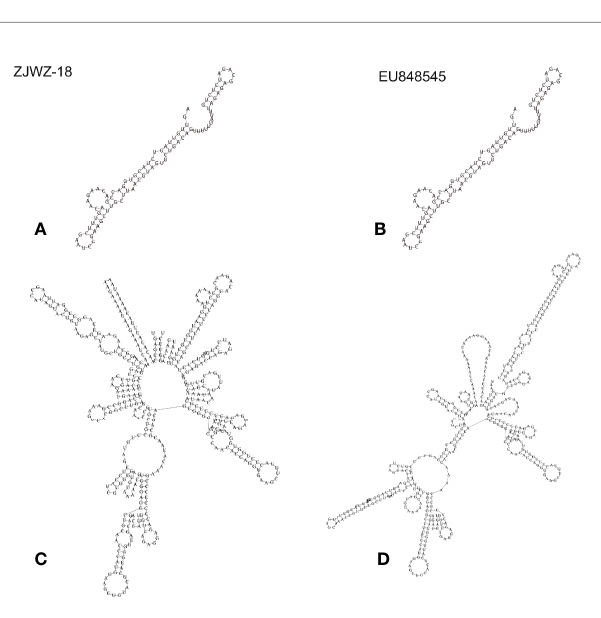
FIGURE 7 | The predicted secondary structure of UTRs of the Wenzhou local strain and standard strain. (A, C) represent Wenzhou local strain ’ s 5 ′ UTR and 3 ′ UTR respectively. (B, D) represent the standard strain ’ s 5 UTR and 3 ′ UTR, respectively.